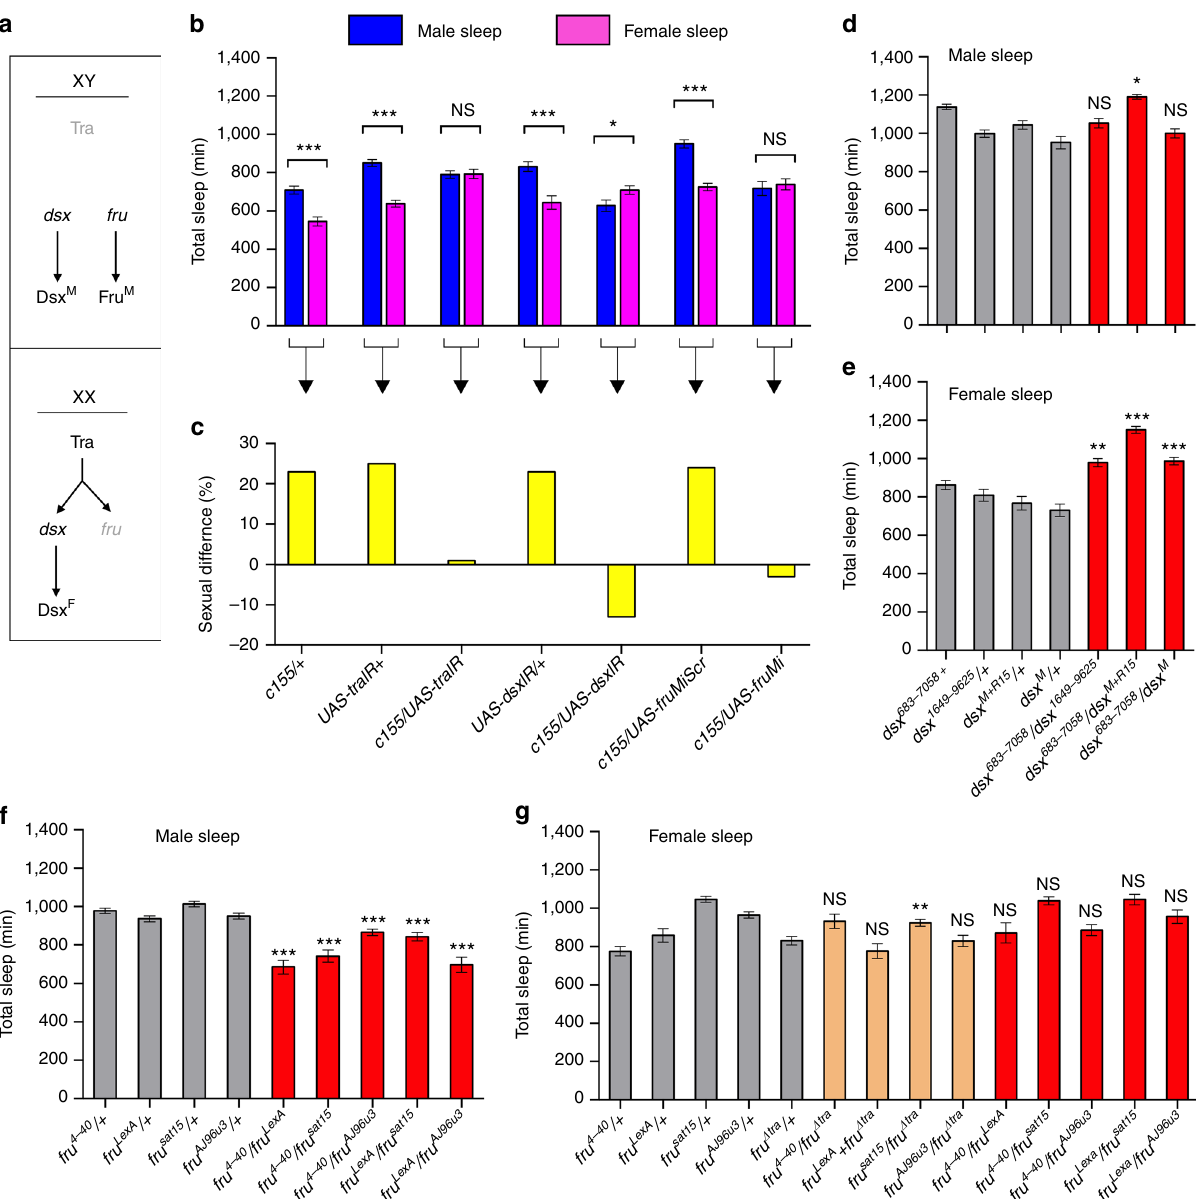
Fig. 8 Sex determination genes regulate sleep. a Sex determination pathway in Drosophila . b , c Sex determination genes tra , fru M , and dsx regulate sexually dimorphic sleep quantity. Total sleep amounts of males and females b , and the corresponding sexual difference of sleep c are shown for indicated genotypes. n = 24~56 for each. * p < 0.05 and *** p < 0.001, unpaired t- test. NS , not signi fi cant. d – g Total sleep in males ( d ) and females ( e ) of dsx alleles, and total sleep in males ( f ) and females ( g ) of fru M alleles. n = 24~32 for each. * p < 0.05, ** p < 0.01, and *** p < 0.001; comparisons are made between the genotype and its parental genotypes, one-way ANOVA. NS , not signi fi cant. Error bars indicate